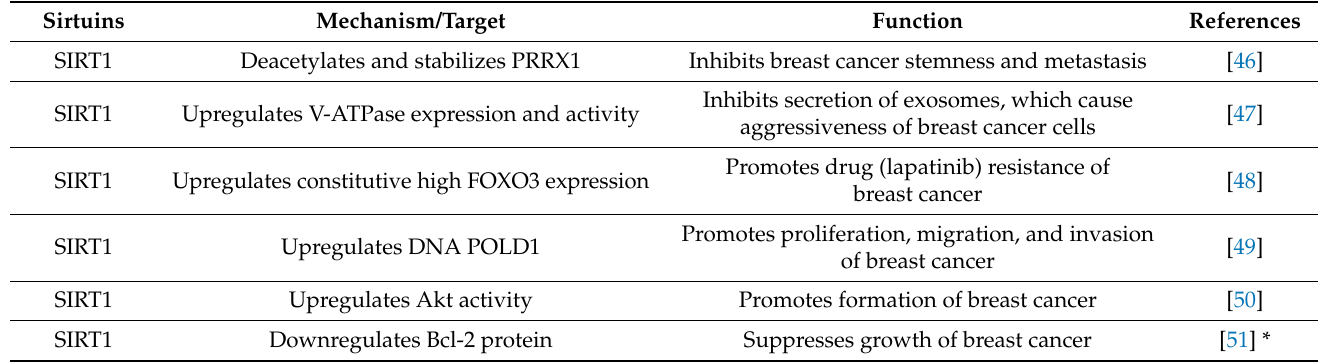
Table 1. Mechanistic Roles of Sirtuins (SIRT1–7) in Breast